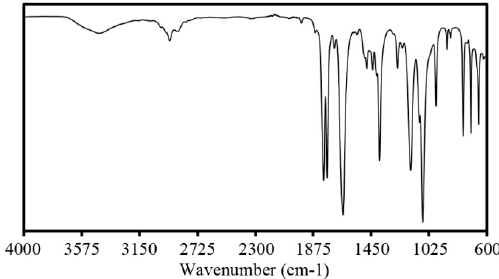
Figure 4. FTIR spectra of the PhCh–(LiI:CsI:BMII) GPE.